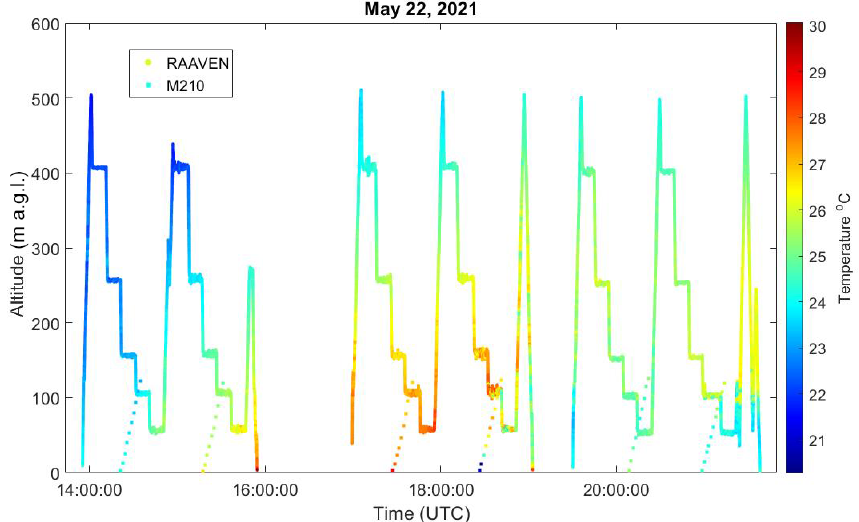
Figure 11. Temperatures ( ◦ C) measured from University of Colorado RAAVEN ( (cid:13) ) and the M120 ( (cid:3) ) on 22 May 2021. RAAVEN was flying over-prairie circular spirals in pattern A.